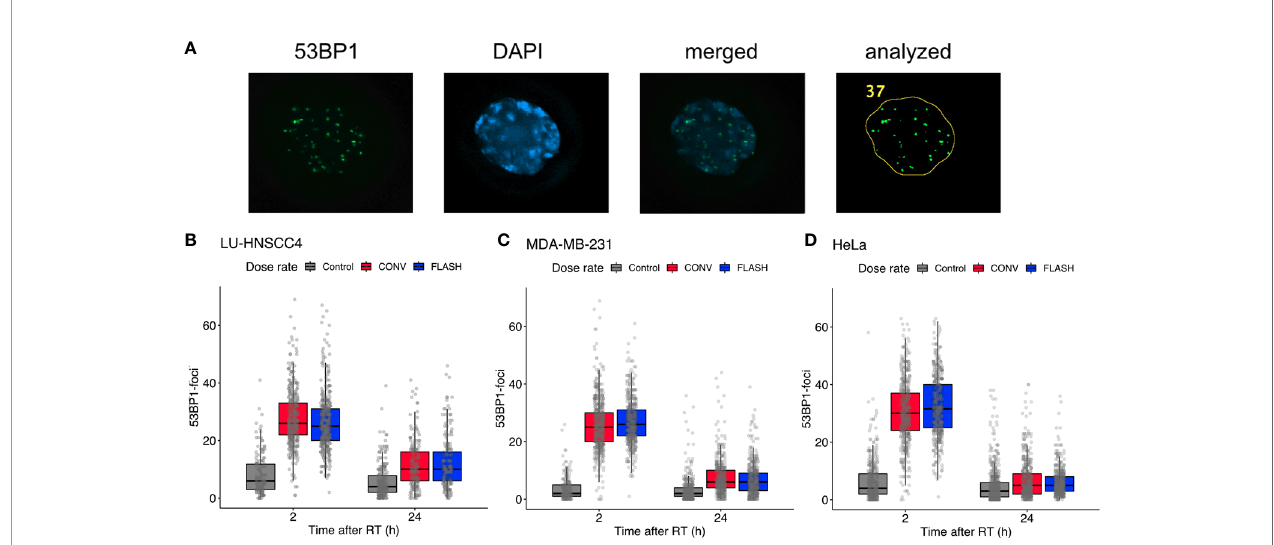
FIGURE 2 | Evaluation of radiation-induced DNA-double strand break foci using 53BP1. (A) Representative microscopy image showing (left to right) 53BP1, DAPI, merged image, and the resulting analyzed image after processing in ImageJ. (B – D) Number of 53BP1 foci at 2 h and 24 h after 3 Gy irradiation with FLASH (blue) or conventional dose rate (CONV, red) compared with controls (grey) for LU-HNSCC4 ( B ; 1,532 scored cells), MDA-MB-231 ( C ; 2,583 scored cells), and HeLa subclone ( D ; 2,973 scored cells). The box and whisker plots illustrate median (thick line), interquartile range (box) and the lowest/highest observation within ±1.5* interquartile range (IQR) from the box (whiskers). The individually scored cells are indicated with transparent circles. Data from two independent experiments.